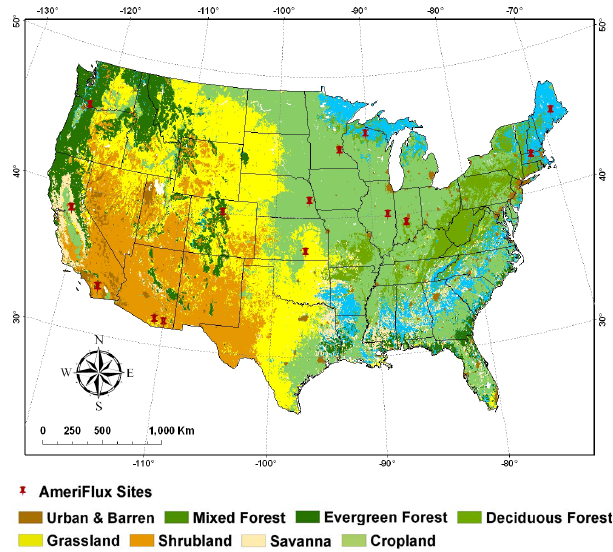
Fig. 1. Land cover map of the conterminous US (0.05 ◦ × 0 . 05 ◦ ) used in regional simulations. The map was re-classified based on MODIS product Land Cover Types Yearly L3 Global 0.05 Deg CMG (MOD12C1). Red pins indicate the location of the Ameri- Flux sites used in this